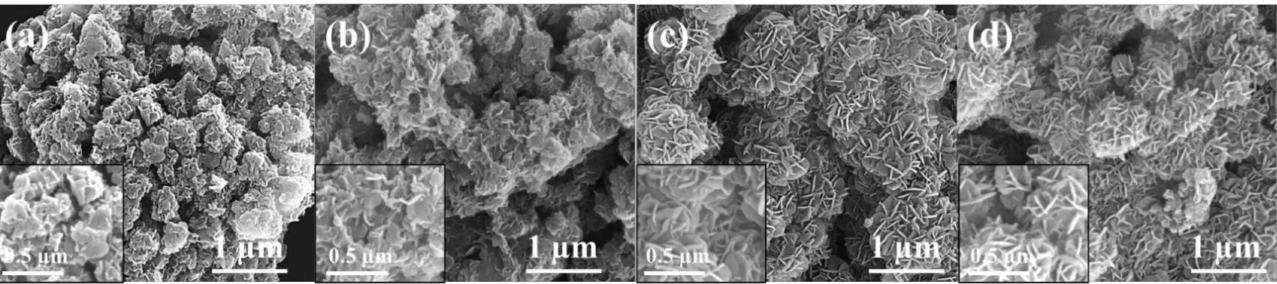
Figure 3. SEM images of ( a )AH-1, ( b ) AO-1, ( c ) AH-2, ( d )